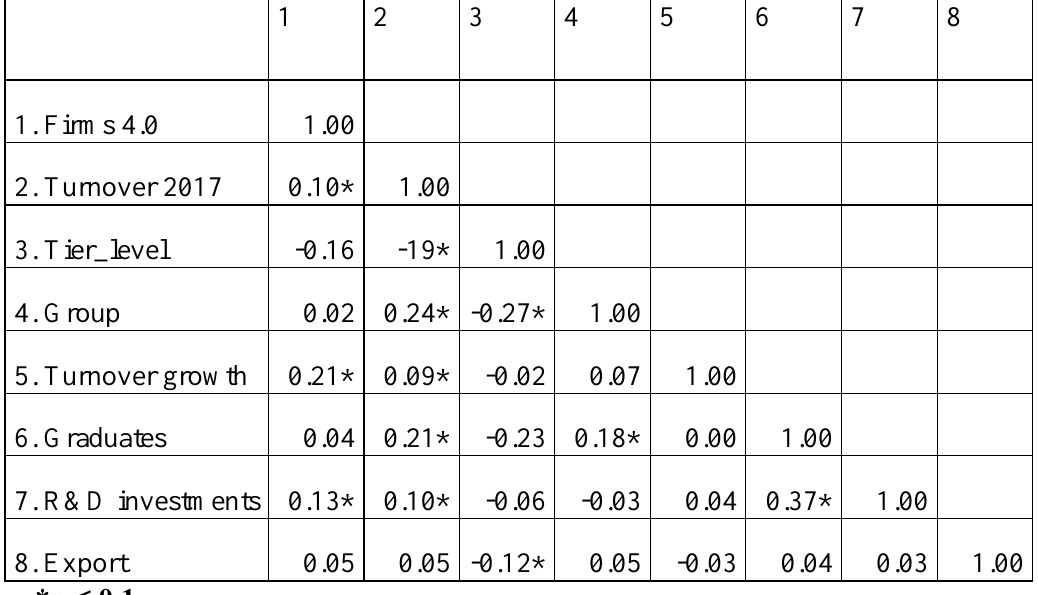
Table 3: Correlations between the Analyzed Variables